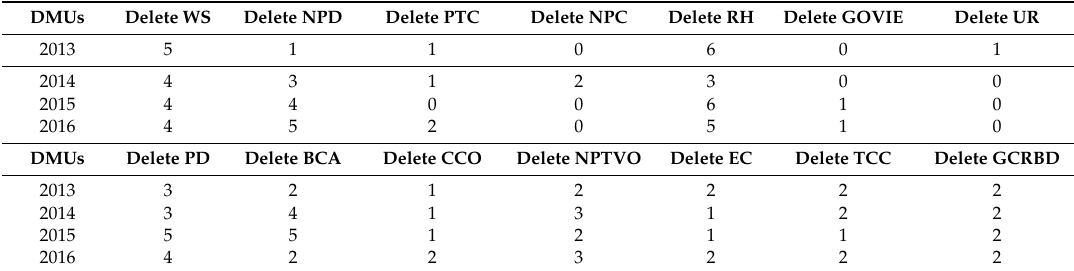
Table 4. The number of cities which stochastic e ffi ciency values changed by deleting single input variable in di ffi dent risk levels from 2013 to 2016.